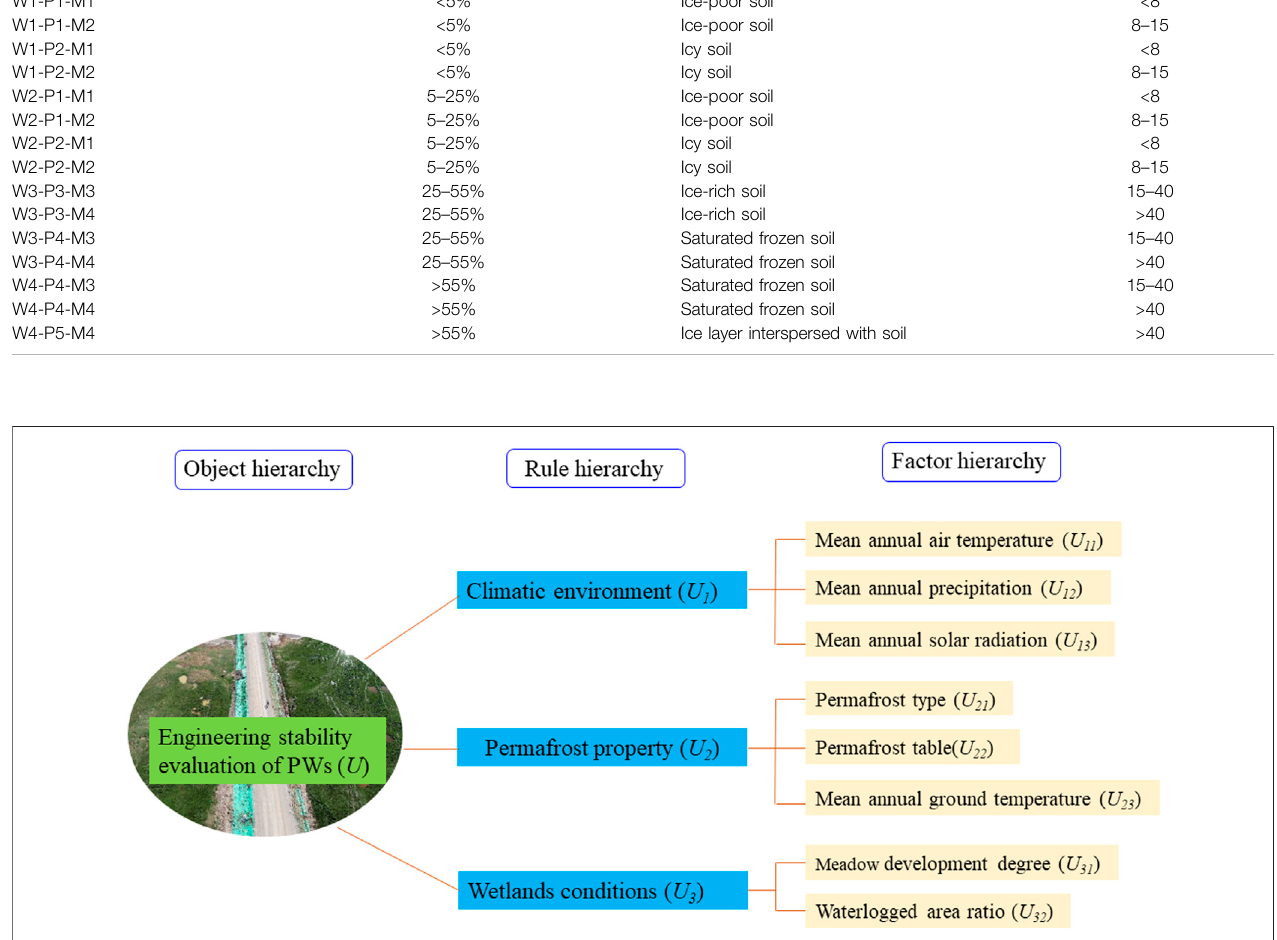
FIGURE 7 | Hierarchical substructure model for engineering stability of permafrost